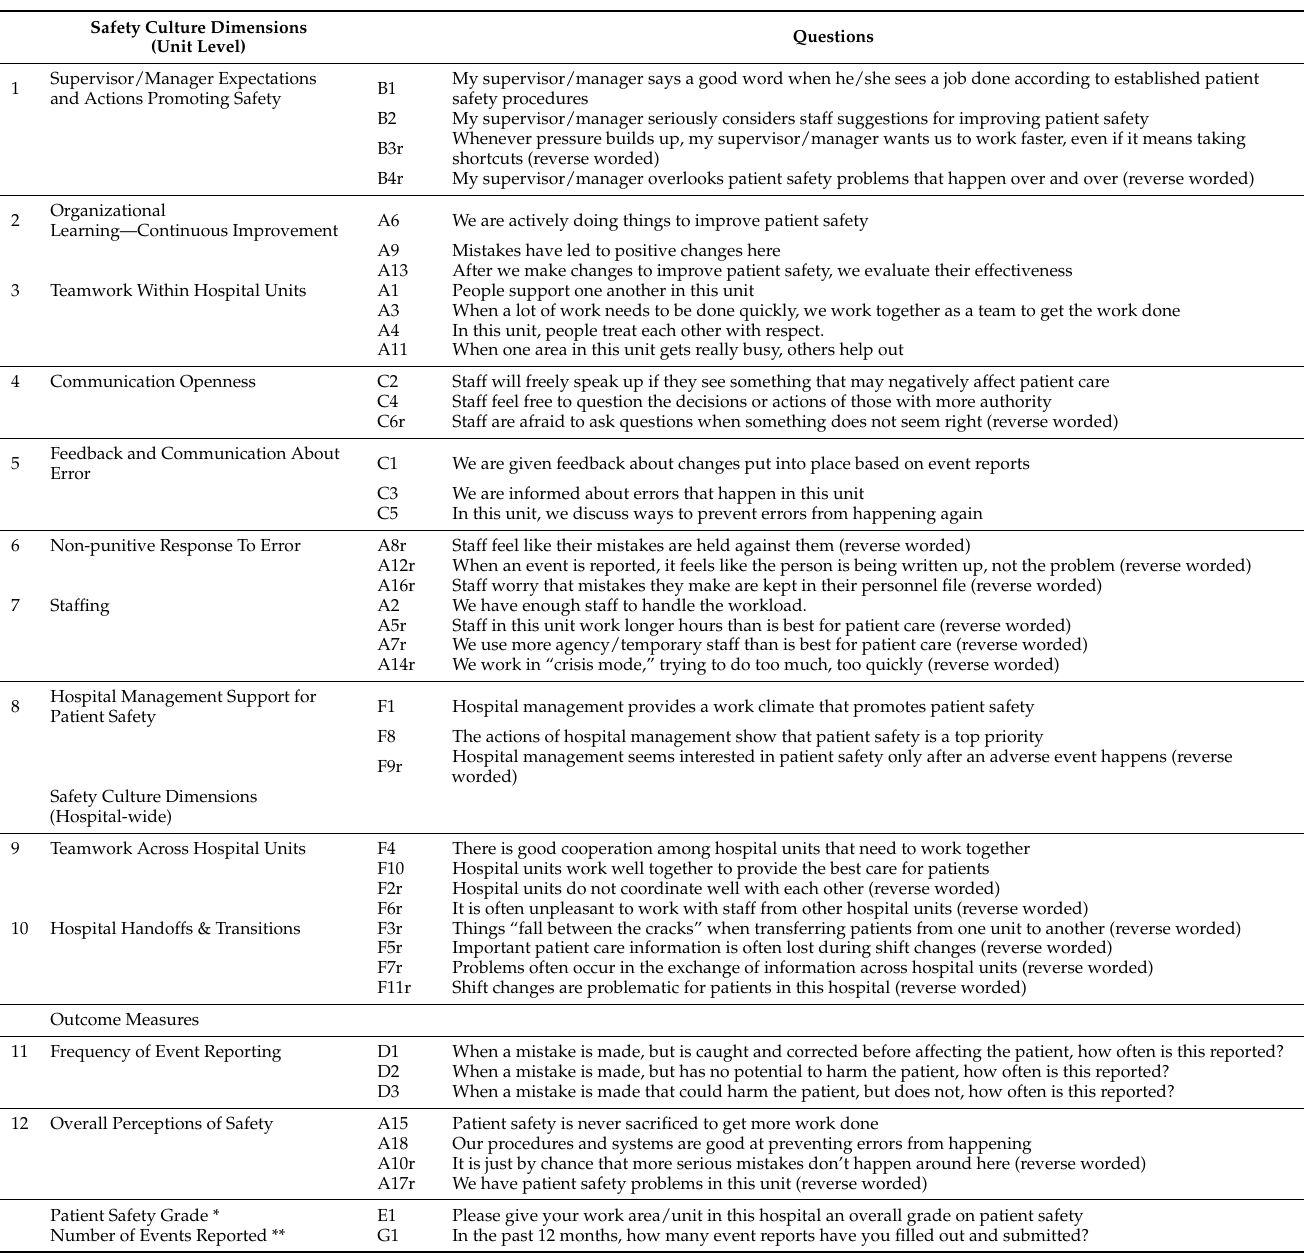
Table 1. PSC dimensions and questions